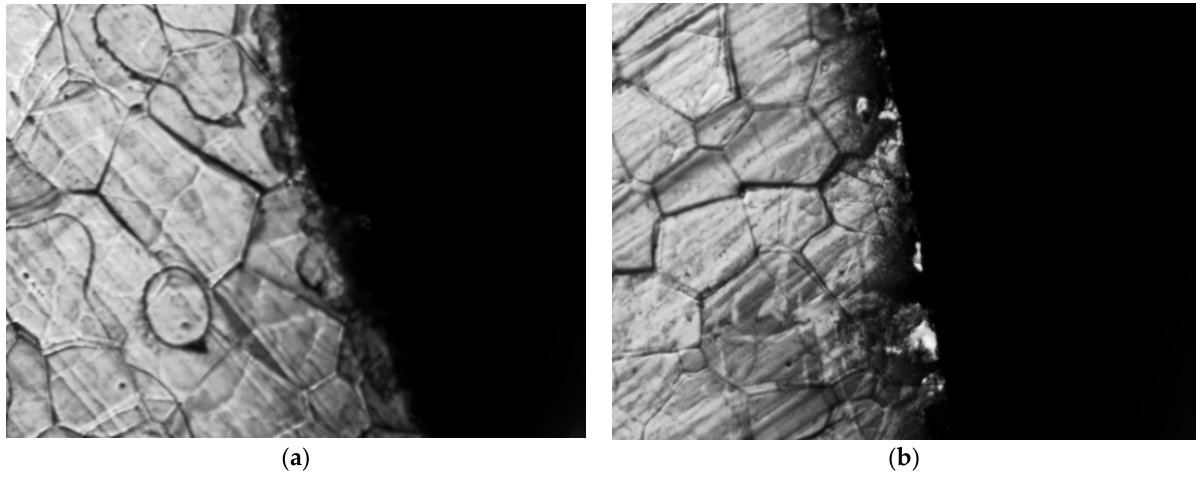
Figure 19. Changes in grain structure at the edges of high silicon steel after grooving in two different ways. ( a ) WEDM. ( b ) Laser cutting.